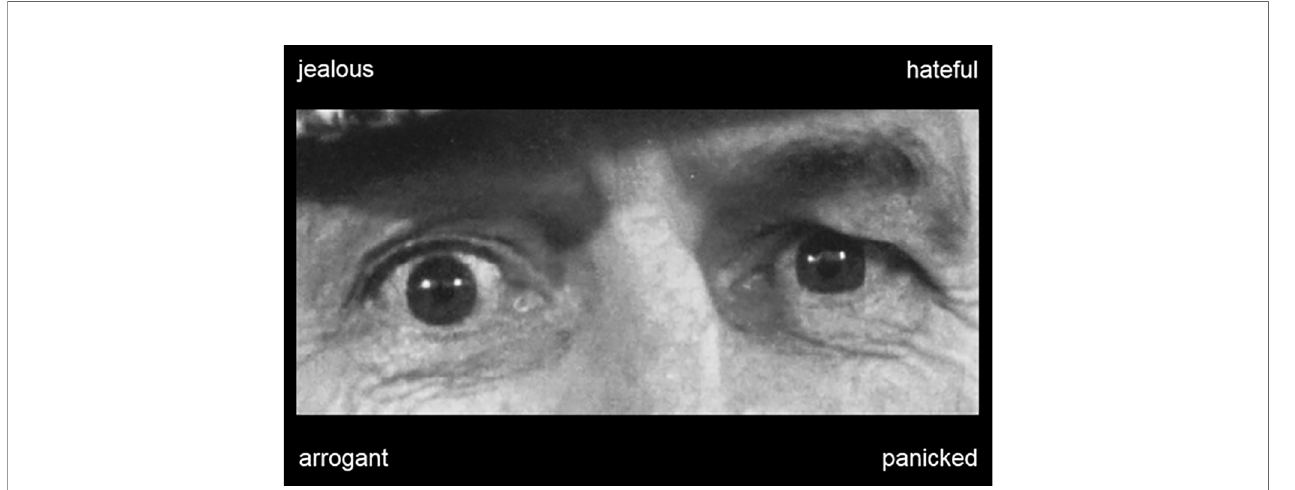
FIGURE 1 | Example of a picture that was used in the original Reading the Mind in the Eyes Test [RME-T, (19)]. The picture shows an eye region expressing a distinct emotional state and labels describing a range of emotional states (one target state, three distractor states). Participants had to identify the label that correctly described the state of the expressed emotion